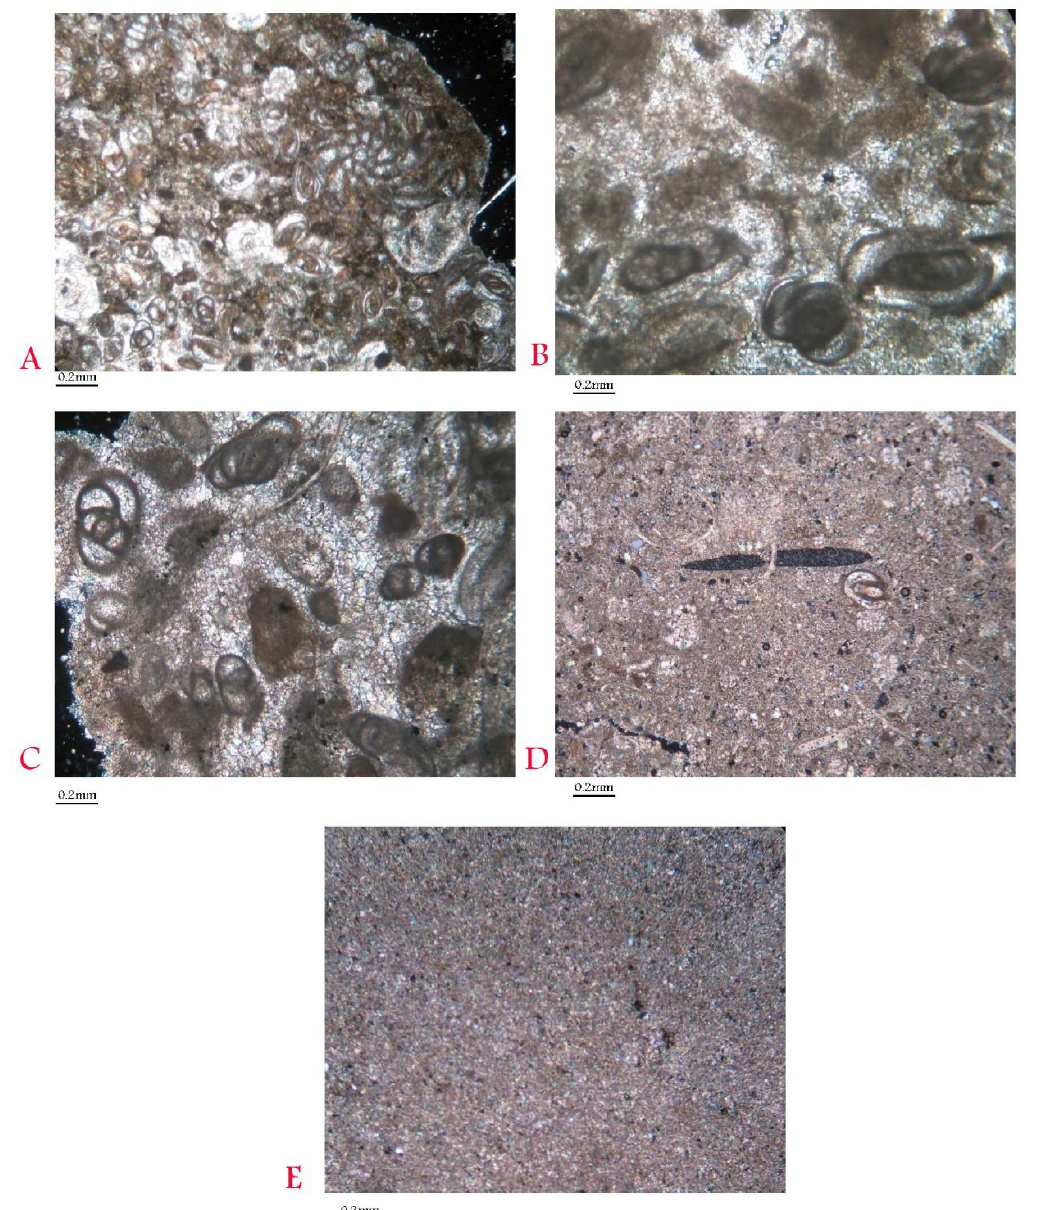
Figure 3. A- Fossilized carbonate sediment (milliolide Paxton), B- Milliolide Paxton with fossil cavities filled by dolomite,